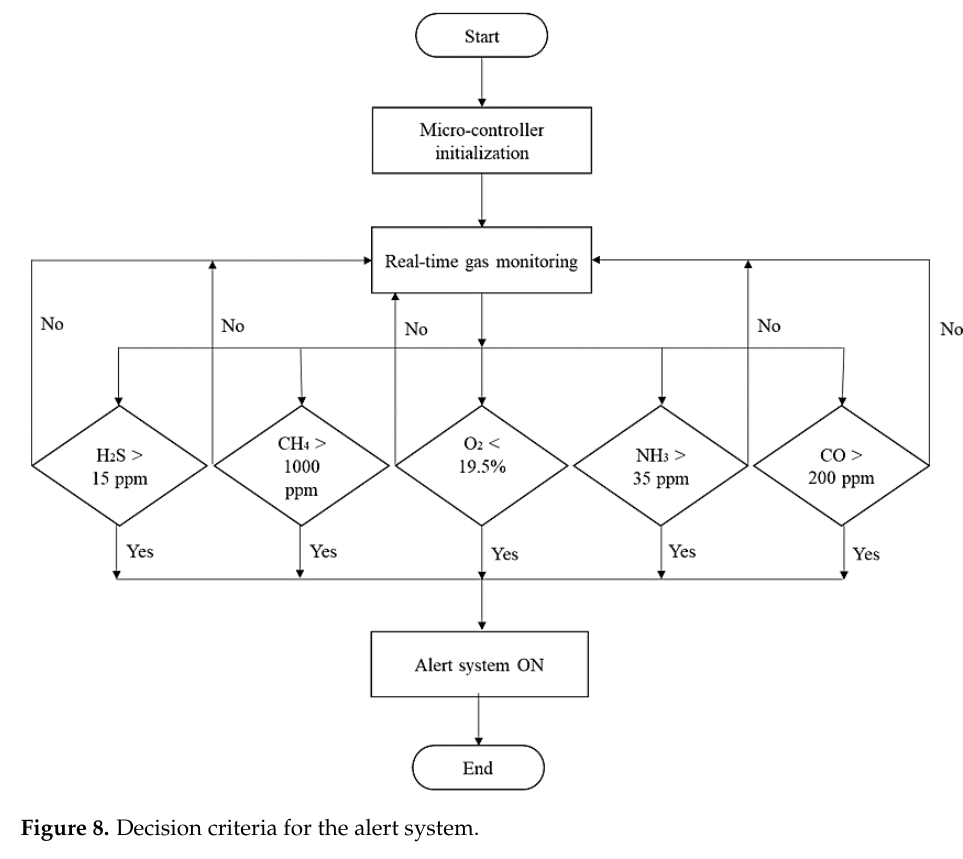
Figure 8. Decision criteria for the alert system.